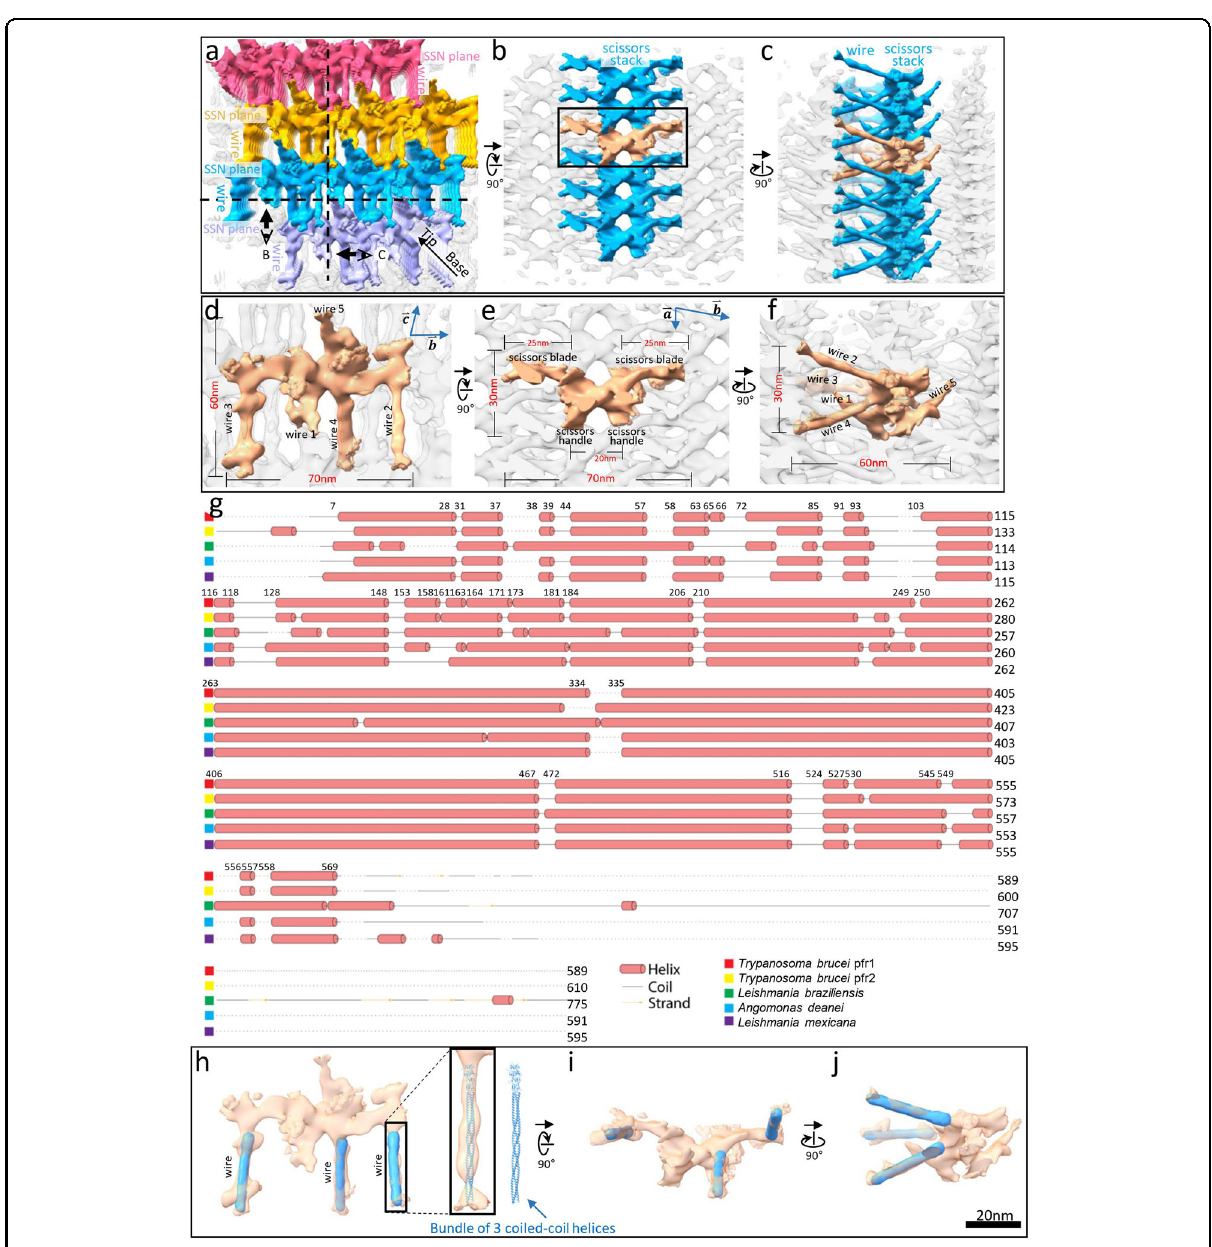
Fig. 3 Paracrystalline network of the PFR distal zone and structural interpretation of subunits. a An overall surface view of a PFR distal zone encompassing four SSN planes (different colors) and their connecting wires, showing the paracrystalline arrangement. The view is looking at the PFR distal zone from the axoneme. b , c Two orthogonal surface views of a at the sectional planes indicated by the dashed lines in a , showing a single scissors density with wires (tan) in a stack (blue) and joined to adjacent scissors stacks (gray), forming an SSN plane of the paracrystalline zone. d – f Three orthogonal zoom-in views of a single scissors density with wires (tan) within the paracrystalline distal zone (gray). Viewing directions in d , e , and f are the same as in a , b , and c , respectively. g Predicted secondary structures of major PFR proteins from the indicated organisms, shown according to their sequence alignment. Amino acid residue numbers of T. brucei PFR1 are indicated on the top. h – j Three orthogonal views of a single scissors density with wires (transparent tan) showing a 3 coiled-coil helix bundle (PDB: 6GAO) 103 (blue) fi tted into the